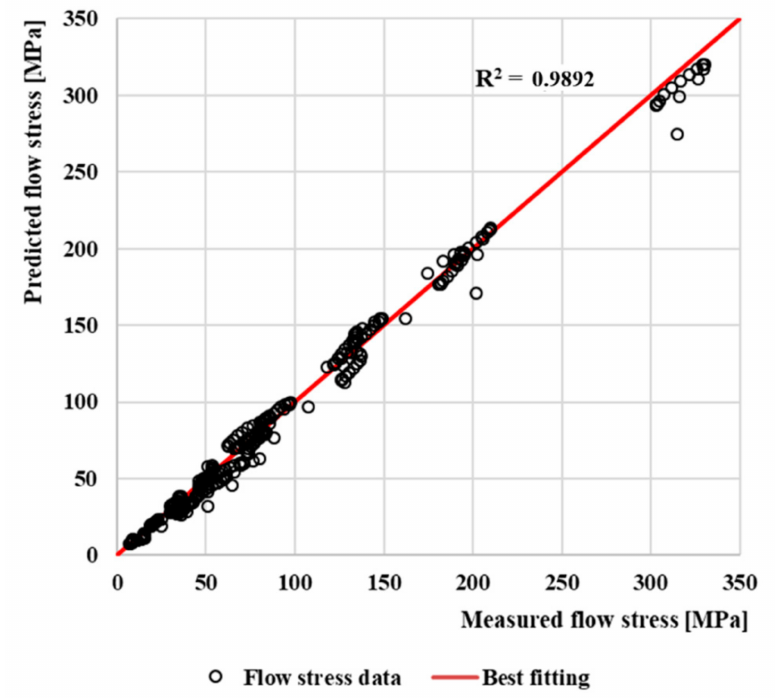
Figure 13. The correlation between predicted and measured flow stresses and comparation with best